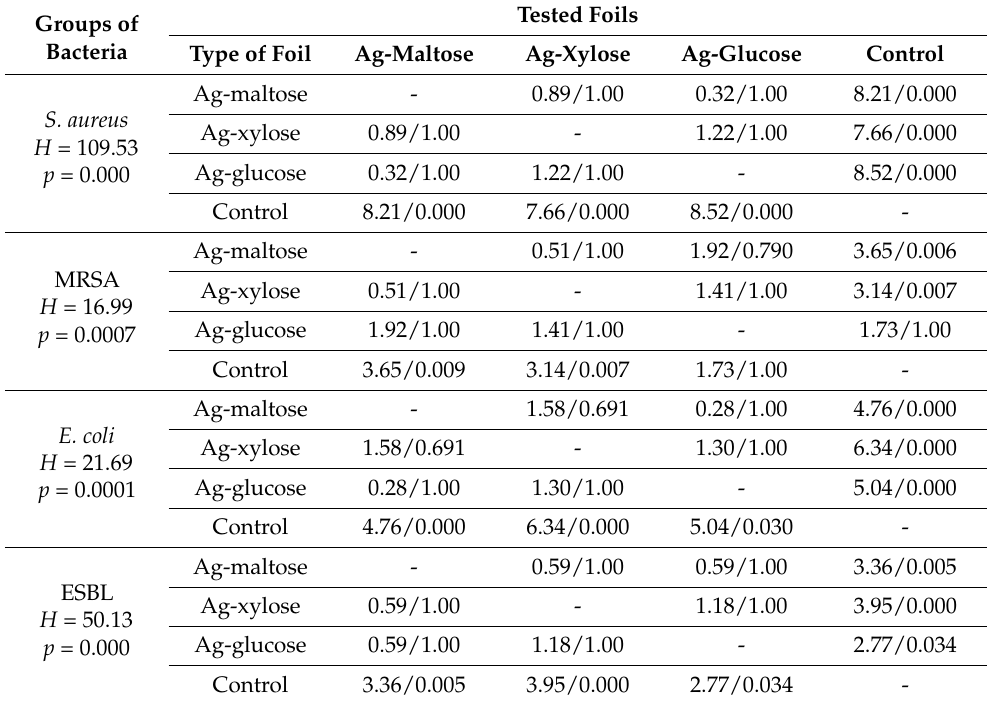
Table 3. Results of Kruskal–Wallis test of significance of differences in antibacterial effects of AgNP foils obtained with various reducing